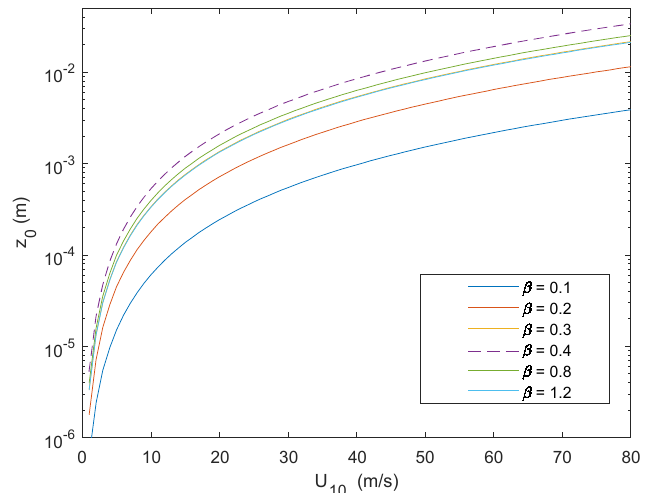
Figure 8. Variations of the sea surface drag coefficient with wind speed under different wave ages, without considering the impact of sea spray droplets. The dashed line ( β = 0.4) indicates that the variation trend of sea surface roughness with wave age began to change.